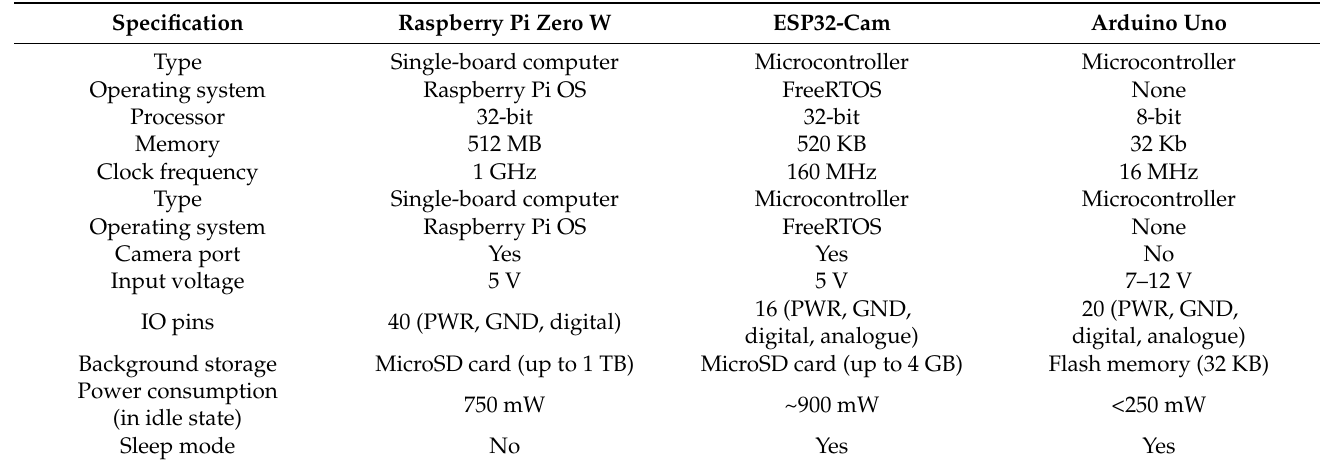
Table 3. Main features of Raspberry Pi Zero W, ESP32-Cam, and Arduino